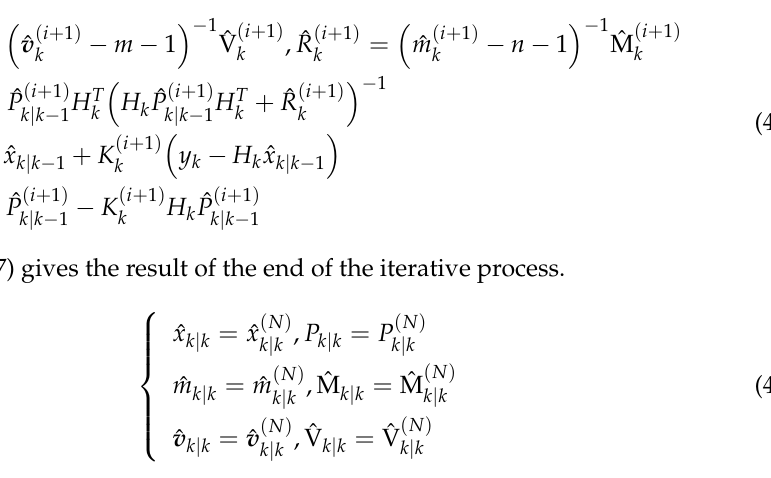
The specific flow chart of the adaptive filter assisted by support vector regression is given as Figure